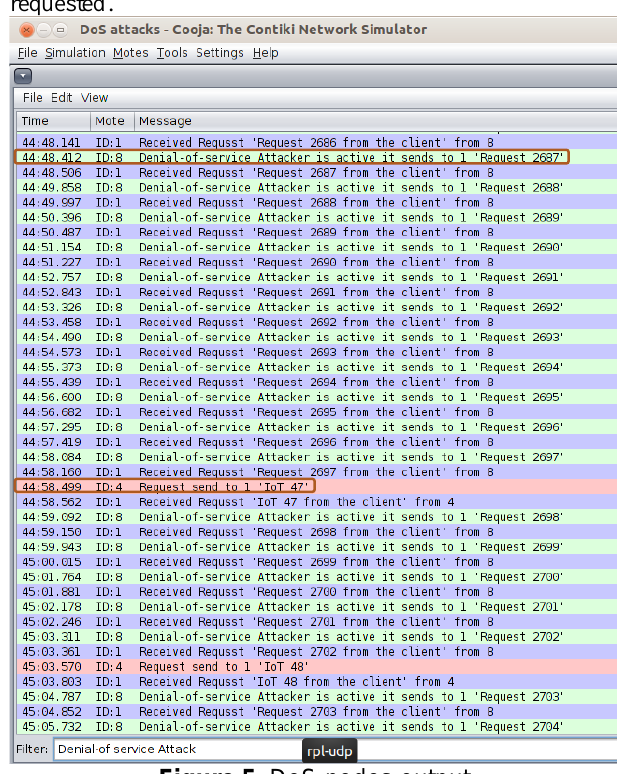
Figure 5. DoS nodes